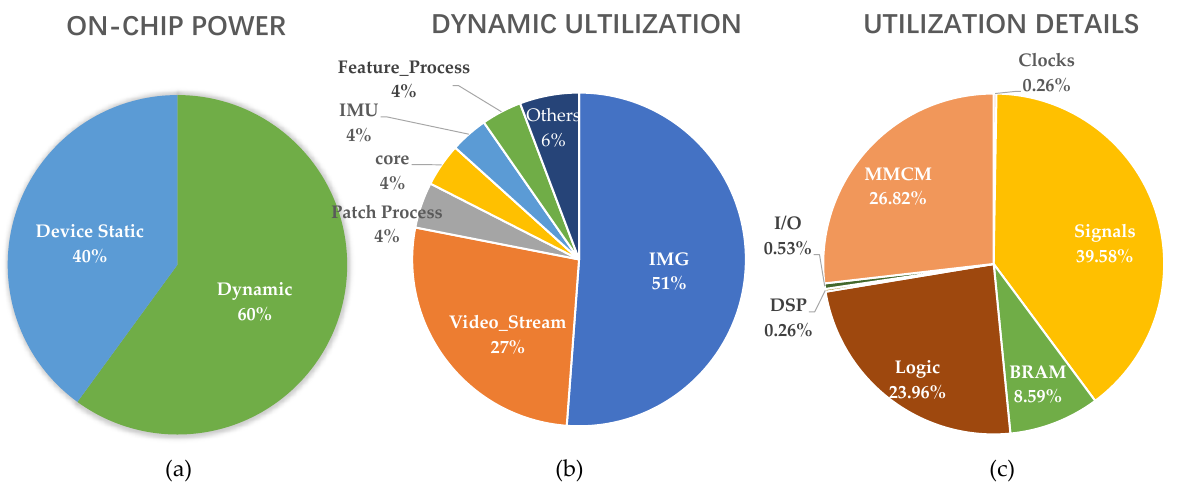
Figure 12. Power proportion of each module. ( a ) on-chip power; ( b ) dynamic utilization; ( c ) utilization details.